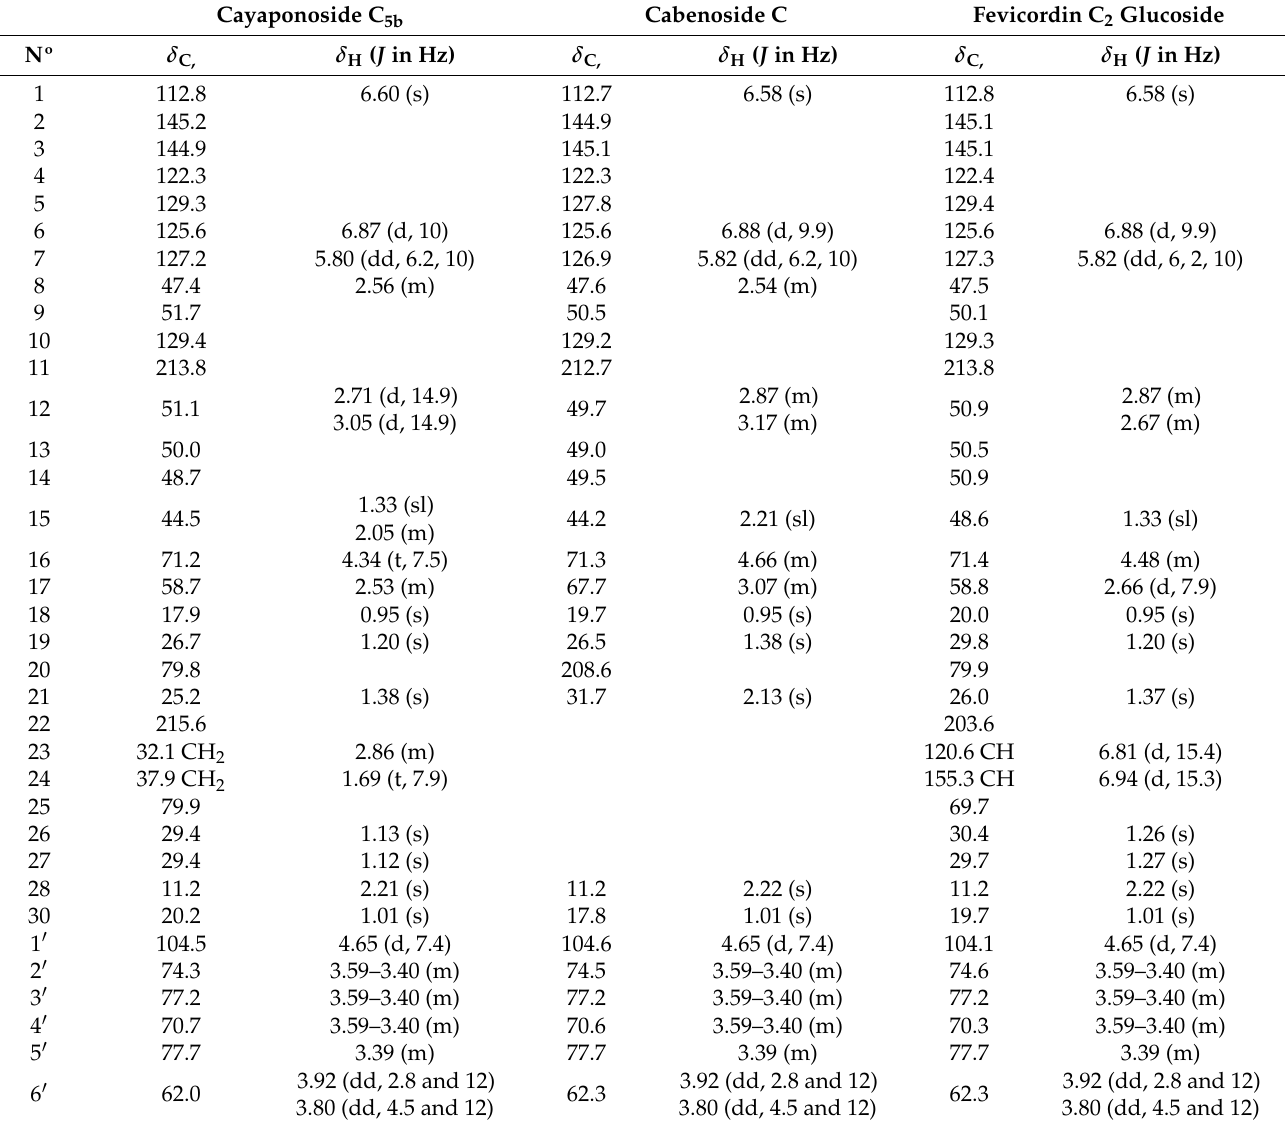
Table 1. 1 H and 13 C NMR spectroscopic data ( δ , Acetone-d 6 , 400 and 100 MHz) of cayaponoside C 5b (Ac-1), cabenoside C (Ac-2) and fevicordin C 2 glucoside